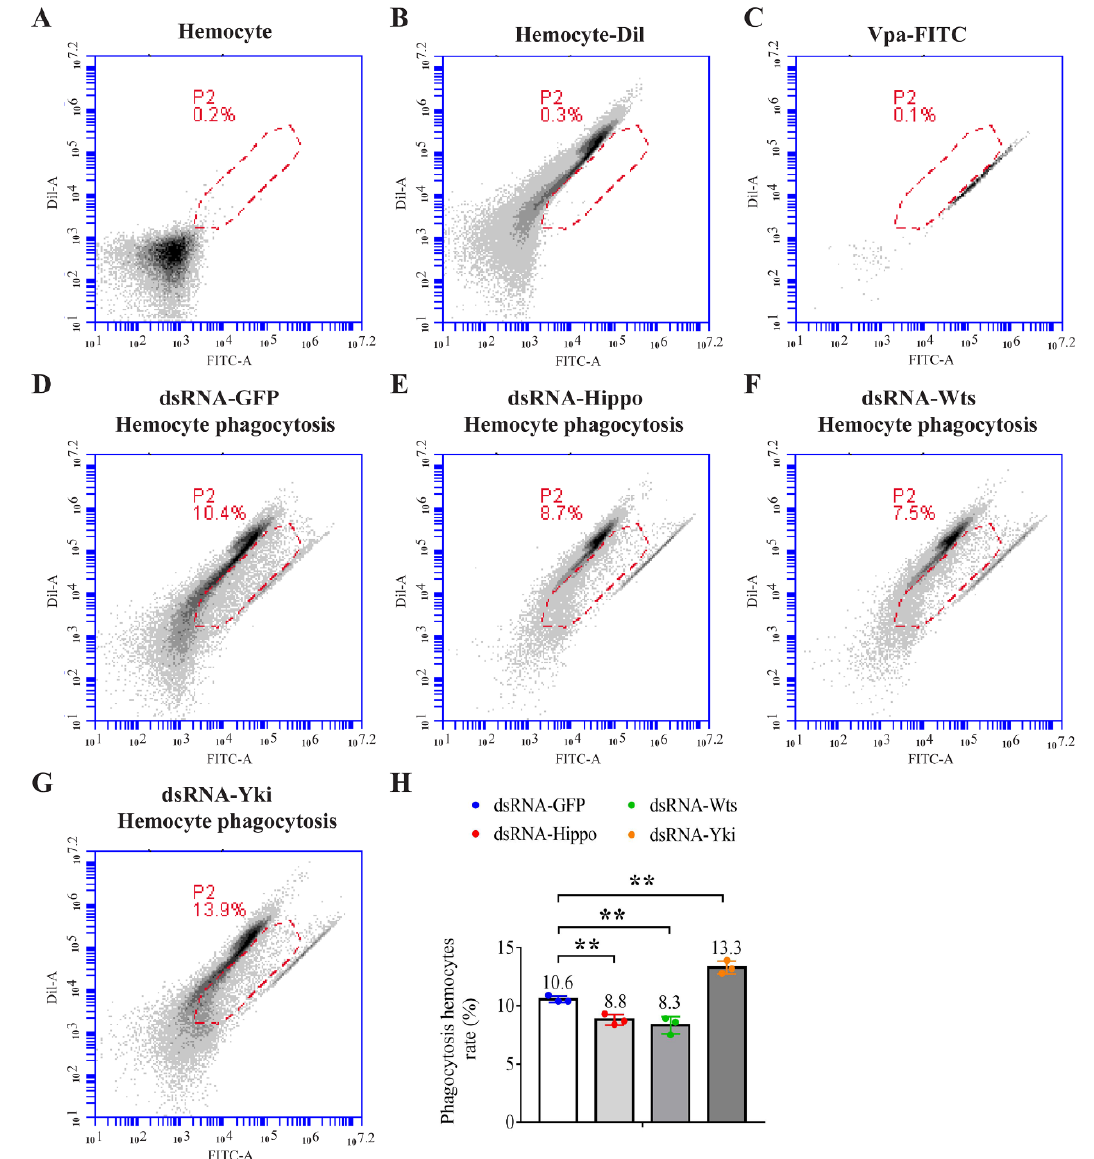
Figure 4. Regulation of hemocyte phagocytosis by the Hippo pathway. ( A – C ) Determination of the fluorescence signal gate of phagocytized bacteria in hemocytes by analyzing the unstained ( A ) and Dil-stained hemocytes ( B ) and FITC-labeled V. parahaemolyticus (Vpa, C ) by flow cytometry. The phagocytic activity of hemocytes of dsRNA-GFP- ( D ), dsRNA-Hippo- ( E ), dsRNA-Wts- ( F ), and dsRNA-Yki-treated shrimp ( G ) were analyzed and statistically analyzed (H). **, p < 0.01 by two-tailed unpaired Student’s t -test.